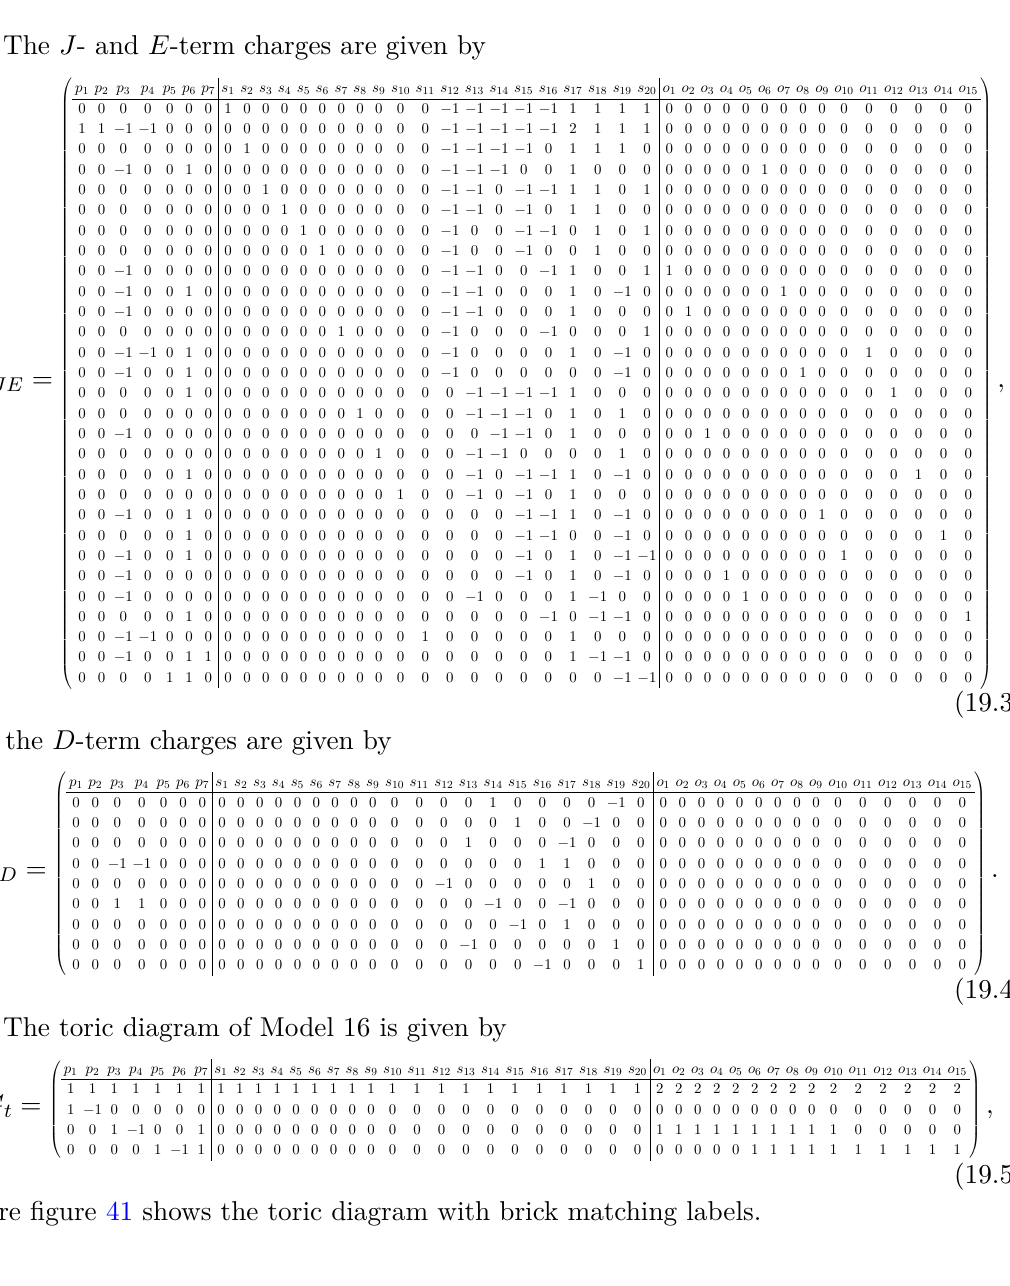
Figure 40 . Quiver for Model